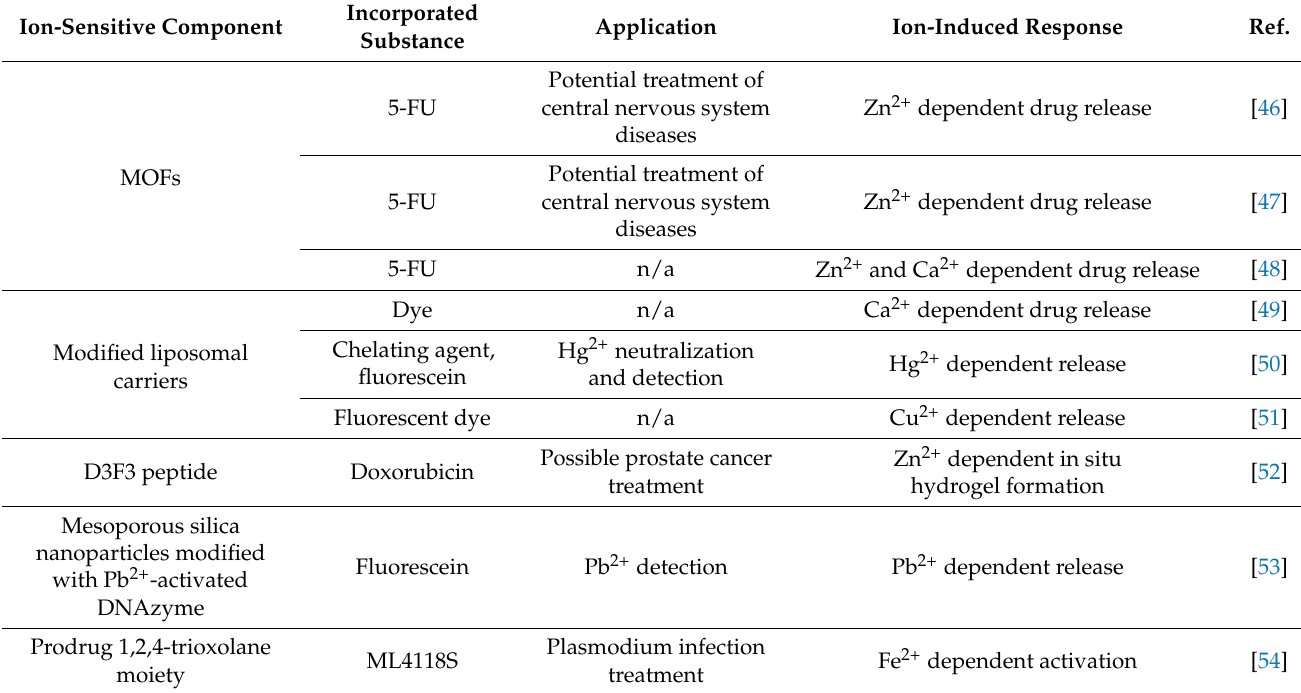
Table 2. Summary of selective ion-responsive systems for pharmaceutical